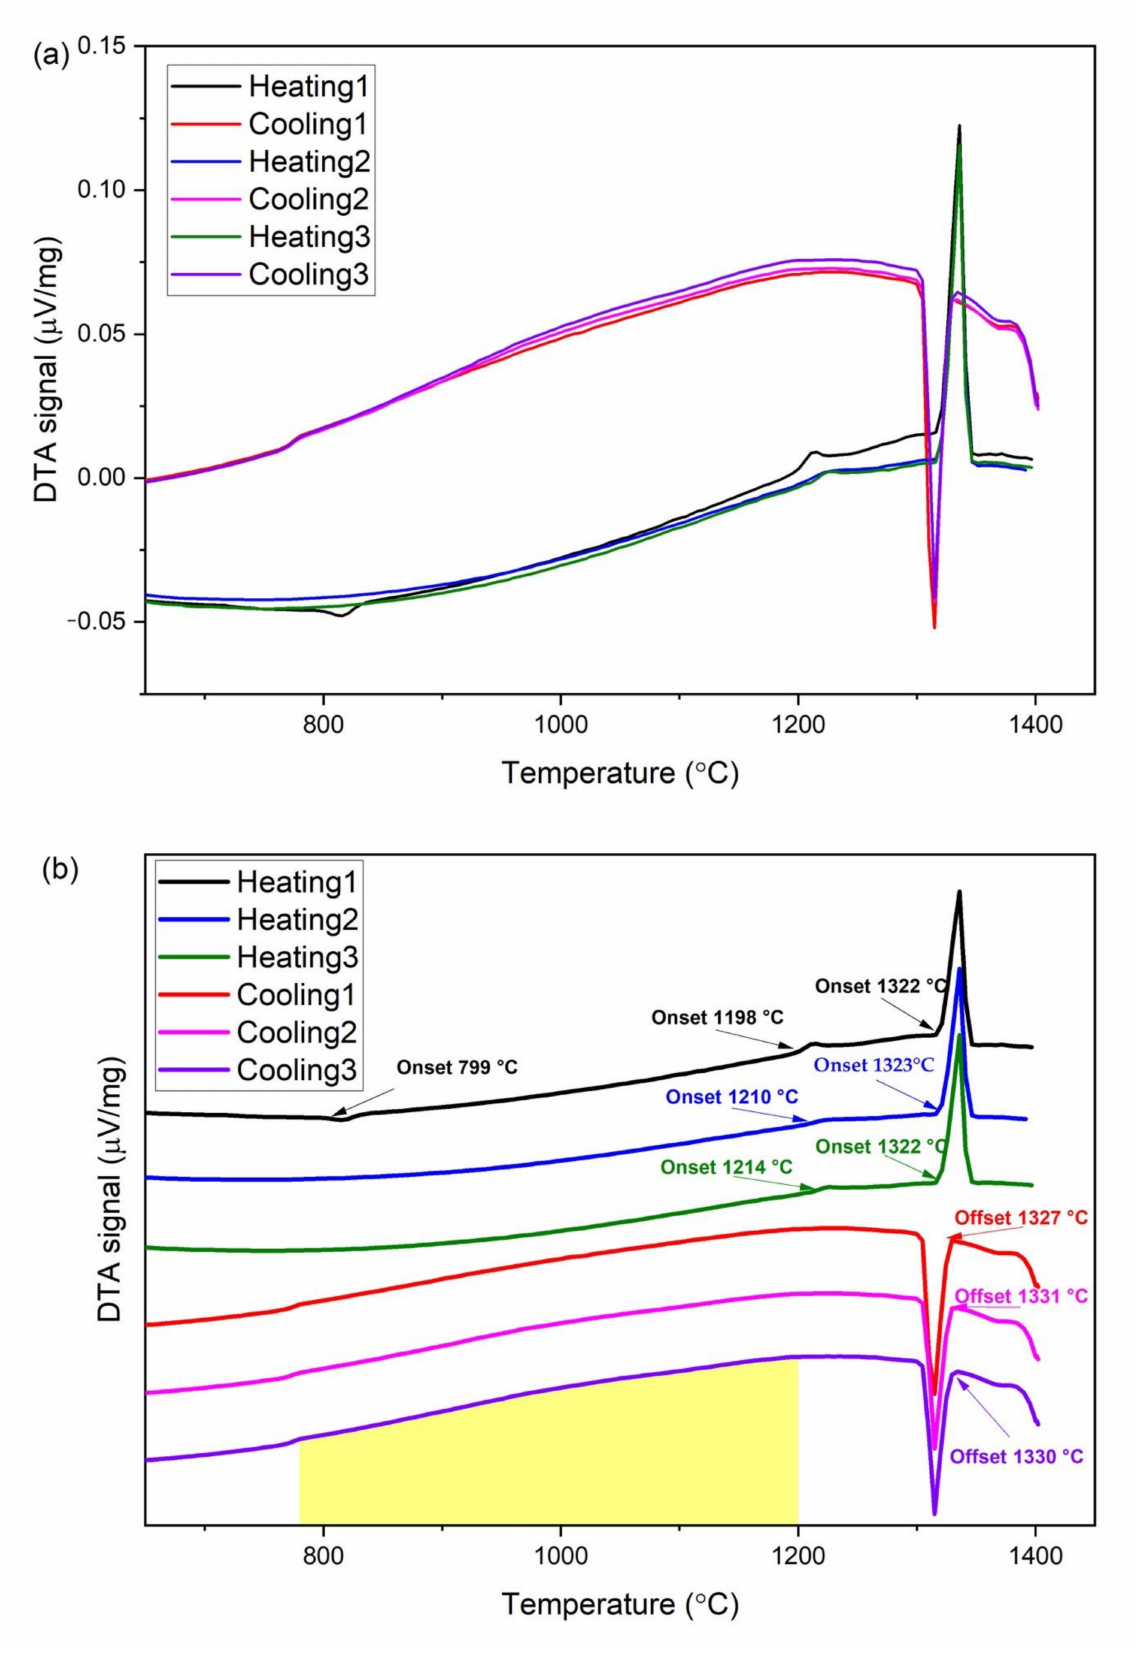
Figure 2. ( a ) DTA curve within same scale and ( b ) enlarged DTA curves highlighted phase transition temperatures of measured CoCrFeMo 0.85 Ni HEA from consecutive heating-cooling